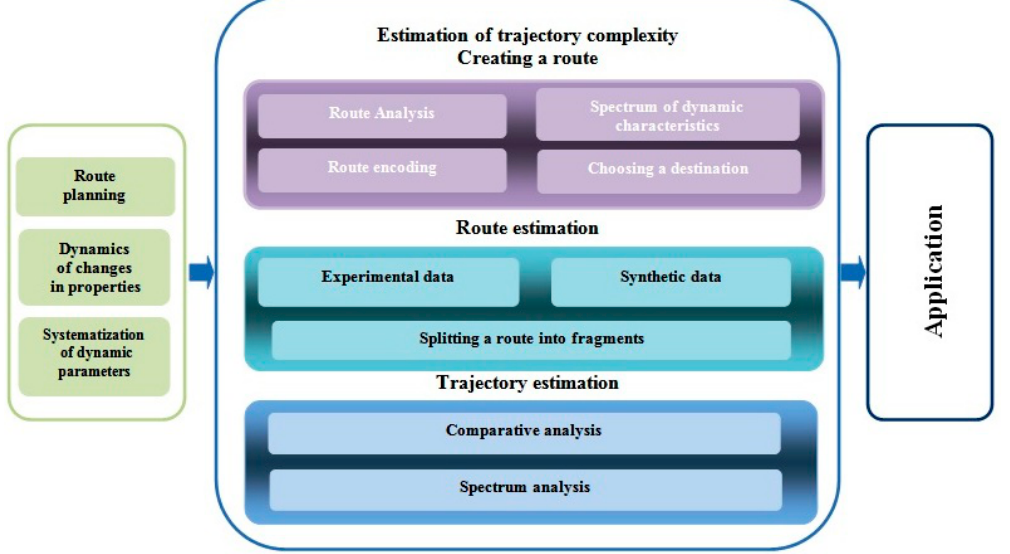
Figure 2. Overview of the proposed algorithm for constructing the optimal path.